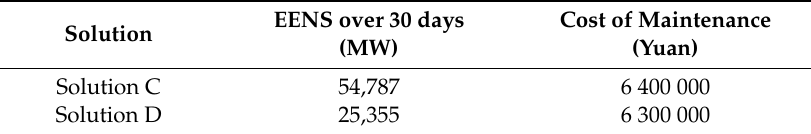
Table 6. Information of transformer to be maintained in Hubei Province.